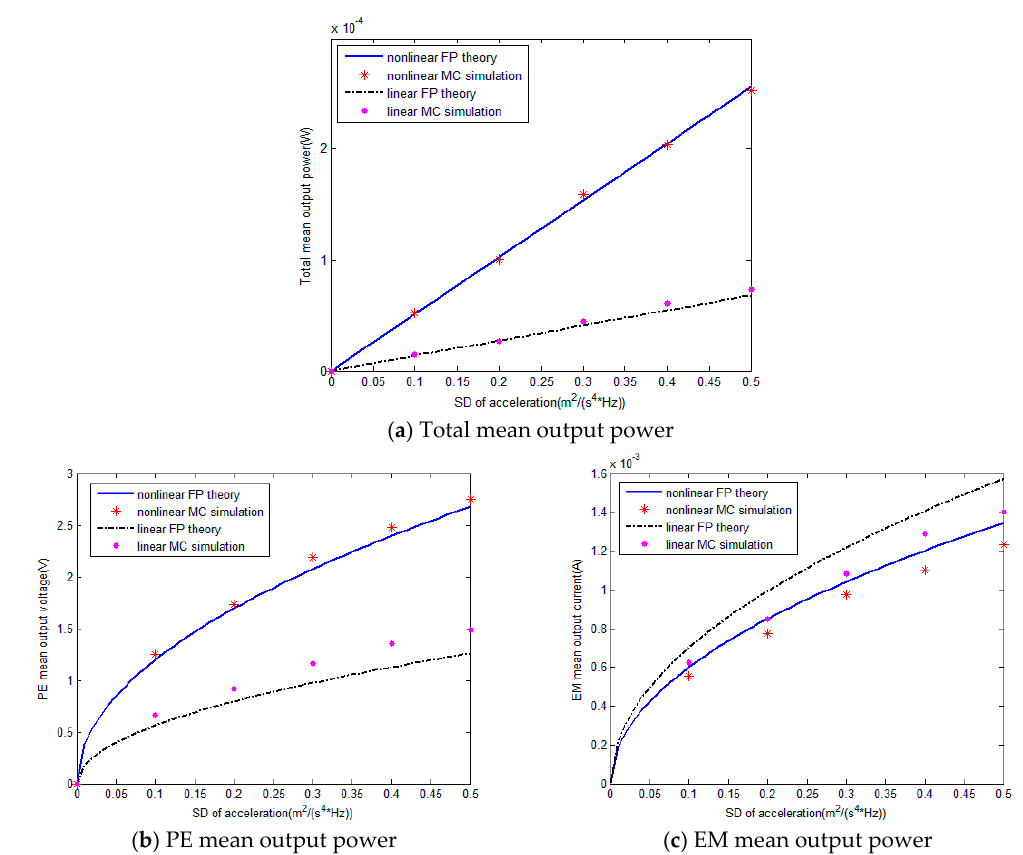
Figure 5. Theoretical and numerical mean output power of hybrid energy harvester with SD of acceleration.